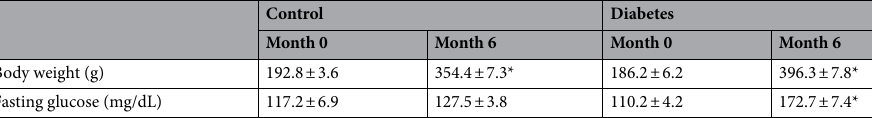
Table 2. Body weight and fasting serum glucose concentration at the start and end of the study in control and type 2 diabetic rats. *Significant difference compared to month 0. Values are mean ± SEM. (n = 6